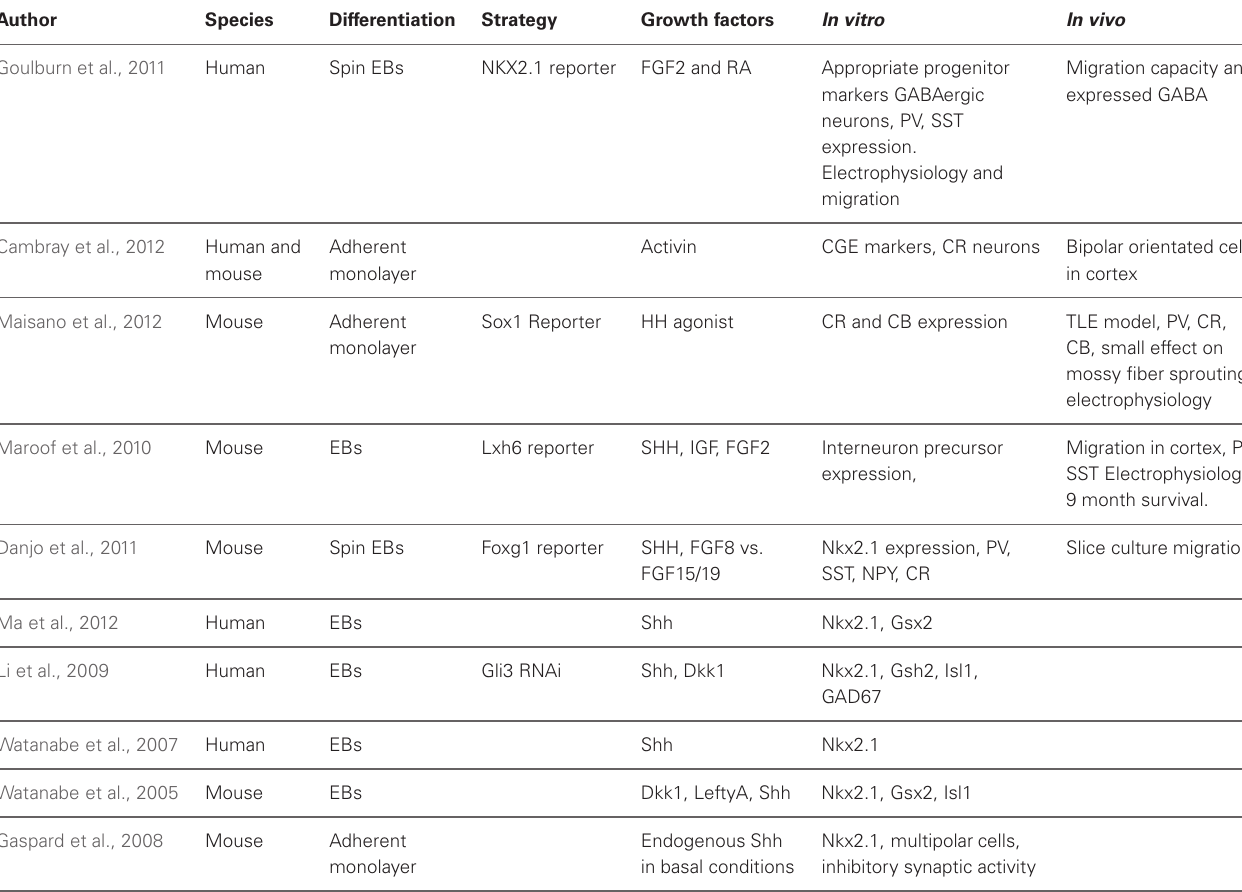
Table 2 | Progress in ESC-derived cortical interneurons and their transplantation in vivo